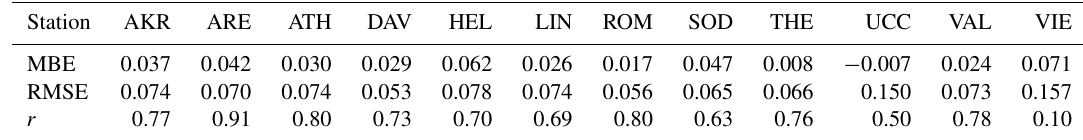
Table 4. Mean bias error of the TEMIS TOC as compared to the WOUDC ground-based measurements. Station AOS ATH DAV MAN ROM SOD THE UCC MBE TOC (DU) 7.6 − 0.9 1.9 5.0 − 9.9 − 5.4 − 2.2 2.9 RMSE TOC (DU) 15.8 10.0 9.1 11.3 12.5 13.1 7.8 r 0.92 Table 5. Comparison results between CAMS-forecasted AOD values used as UVIOS input and AERONET ground-based AOD measure- ments. The AOD MBE and RMSE statistical scores are shown in absolute units along with the correlation coefficient. Station AKR ARE ATH DAV HEL LIN ROM SOD THE UCC VAL VIE MBE 0.037 0.042 0.030 0.029 0.062 0.026 0.017 0.047 0.008 − 0.007 0.071 RMSE 0.074 0.070 0.074 0.053 0.078 0.074 0.056 0.150 0.157 r 0.77 0.91 0.80 0.73 0.70 0.69